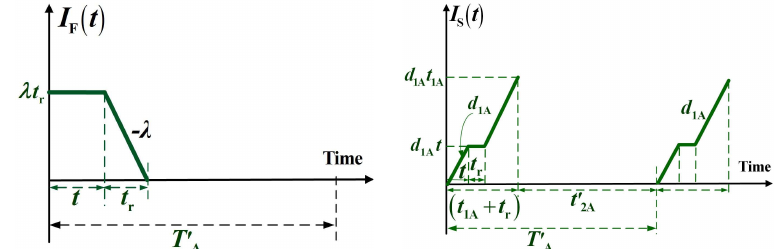
Fig. 3 . The on-hand status of scraps in the proposed system with expedited rate, random failures, and